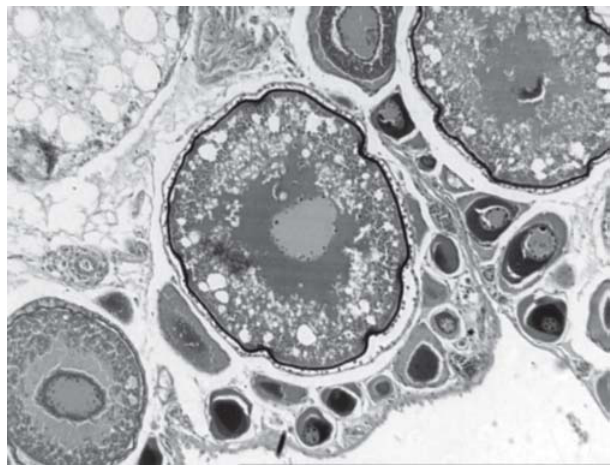
Fig. 5. Merluccius hubbsi: oocyte with lipidic and proteic vitellogenesis (1.5mm length